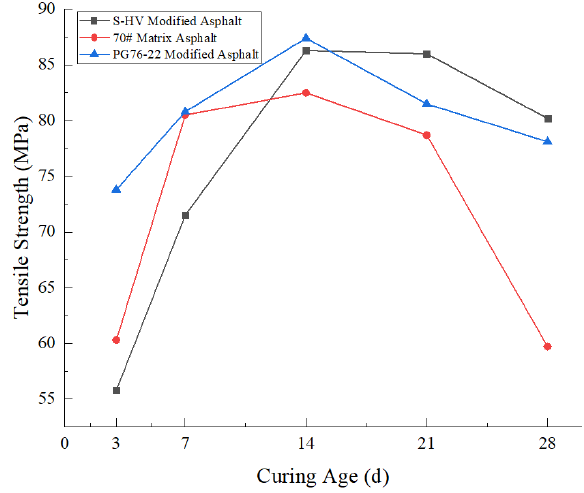
Figure 7. The tensile strengths of the three bitumen materials with the curing age.